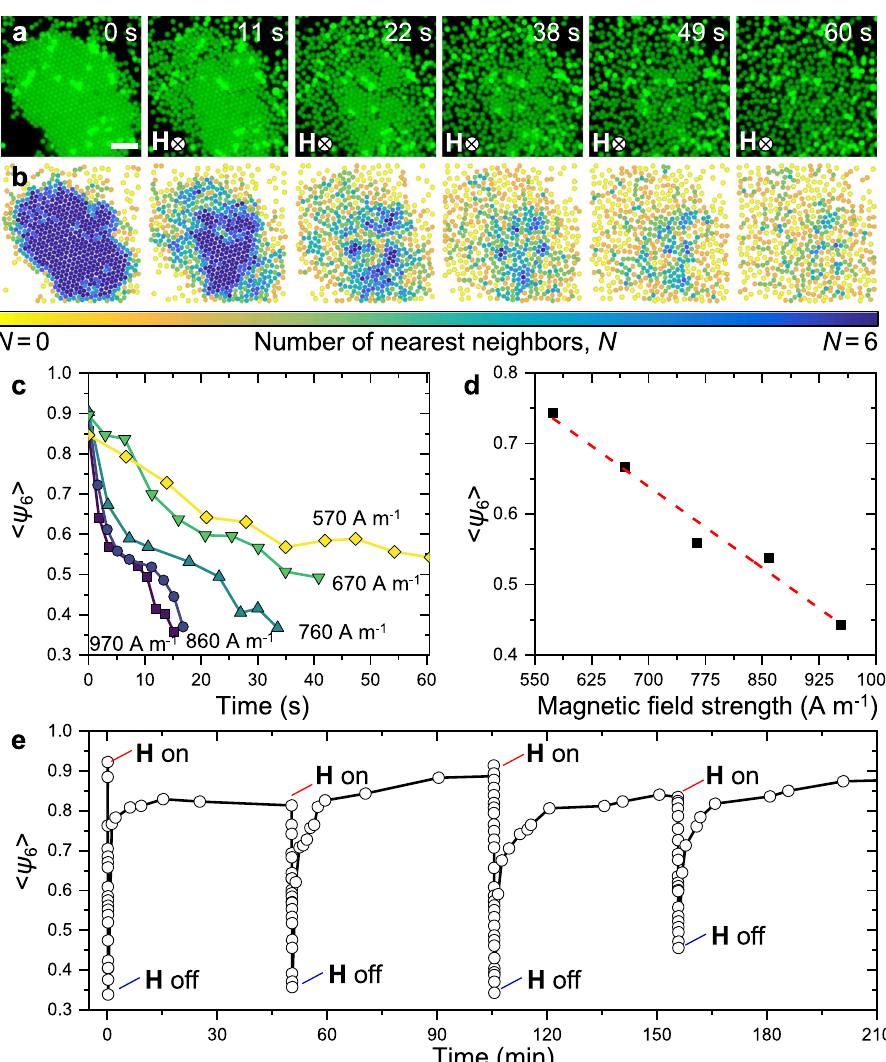
Fig. 3 Assembly and disassembly of colloidal crystals. a Time sequence of frames showing the disassembly of a colloidal crystal at H = 550 Am − 1 and b corresponding color maps of the number of nearest neighbors, N . The disassembly occurs within 60s starting from the edge and defects where crystal bonds are weaker. Scale bar: 10 μ m. c Decrease in global crystallinity quanti fi ed by 〈 ψ 6 〉 for different magnetic fi eld strengths. The values of the H (in Am − 1 ) are provided next to the corresponding curve. d The rate of disassembly decreases linearly with increasing magnetic fi eld strength. All values of 〈 ψ 6 〉 are computed after 10s from initiating disassembly. e Cycles of order – disorder transitions correspond to the assembly of crystals via depletion attraction and their disassembly by introducing an external magnetic fi